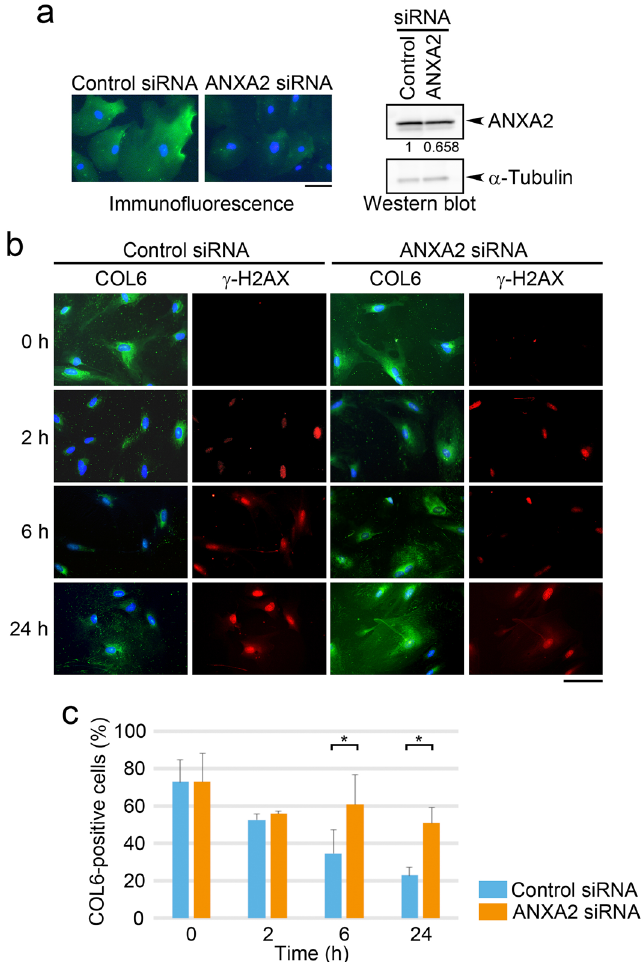
Figure 4. ANXA2 is required for MMc-induced COL6 secretion. ( a ) HRGECs were transfected with control or ANXA2 siRNA, and 48 h post-transfection, the protein levels of ANXA2 were measured by immunofluorescence (left panel) and Western blotting (right panel). The ratio of ANXA2 intensity of ANXA2 siRNA-treated cells versus control siRNA are shown below the ANXA2 blot. Data were normalized to the intensity of α-Tubulin loading control. ( b ) HRGECs transfected with control or ANXA2 siRNA were treated with MMc (12 µg/mL, 2 h). After washout, the cells were cultured without MMc for the indicated number of hours, and immunostained with anti-COL6 and anti- γ-H2AX antibodies. ( a , b ) Scale bar: 50 µm in each panel. ( c ) The percentage of cells with cytoplasmic COL6 (COL6-positive cells) was measured using the samples of b by fluorescent images. A total of more than 100 cells of four independent fields per experiment was analyzed. Statistical significance was determined by the Mann–Whitney U test. * p <